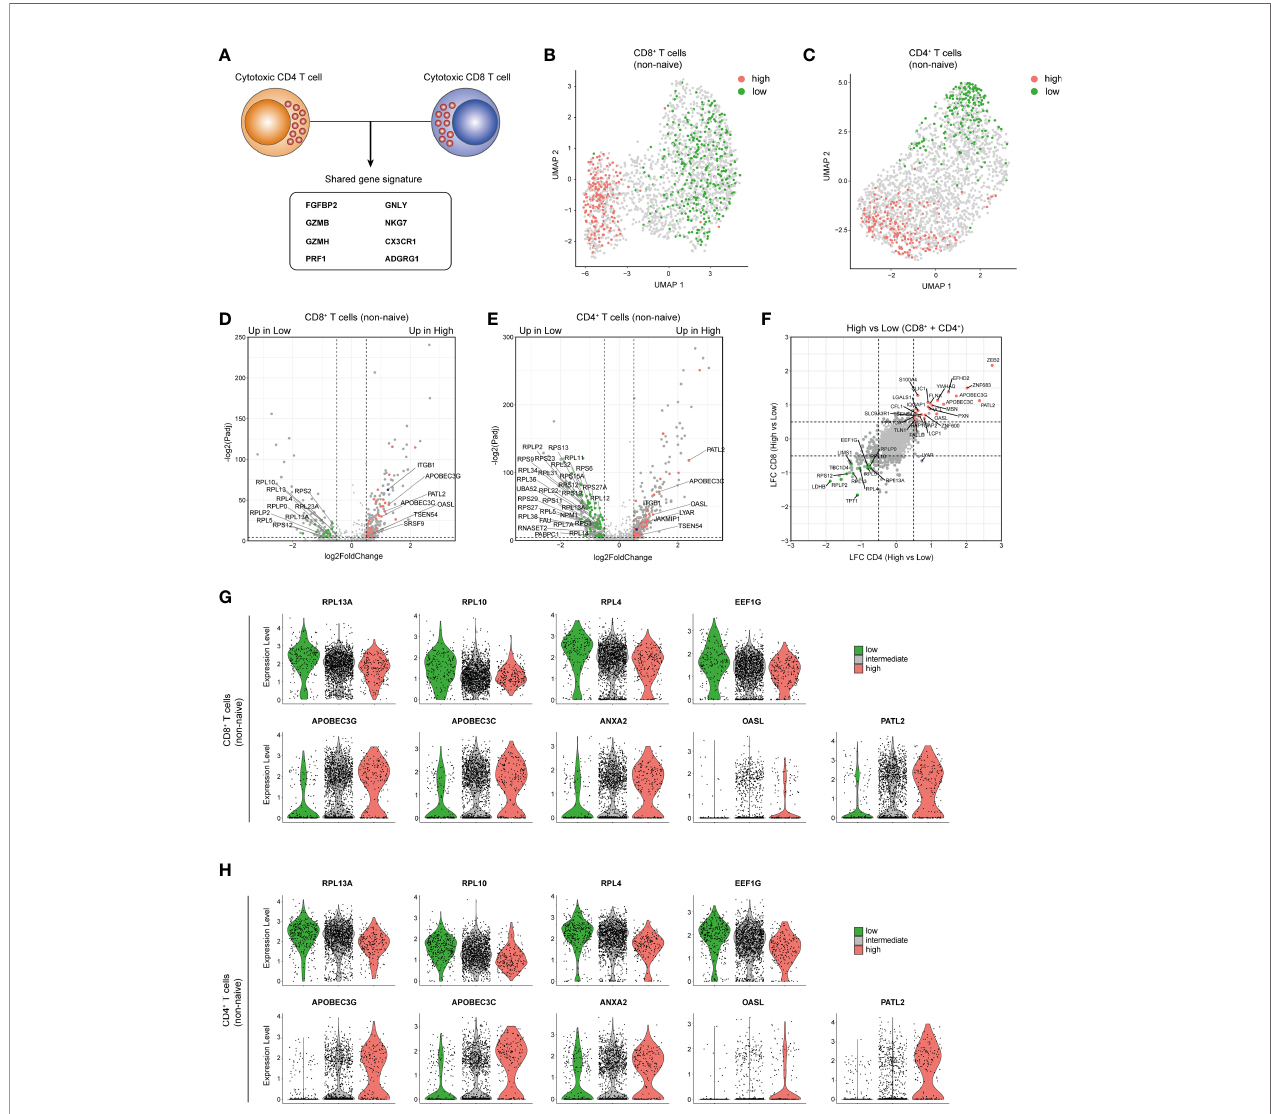
FIGURE 6 | Cytotoxic CD4 + and CD8 + T cells share an RBP expression pro fi le. (A) Diagram indicating the cytotoxic gene signature shared by CD4 + T cells and CD8 + T cells as de fi ned in Supplementary Figures 6E, F . (B, C) Uniform Manifold Approximation and Projection (UMAP) plot on non-naive CD8 + T cells (B) and CD4 + T cells (C) with a high (top 10%, red) or low (bottom 10%, green) cytotoxic score. (D, E) Volcano plot d DE RBPs (red) and other genes (gray) between non- naive CD8 + T cells (D) and CD4 + T cells (E) . Blue dot depicts ITGB1 . (F) Log2 Fold Change values for RBPs with a high or low cytotoxic score of non-naive CD4 + T cells (y-axis) and non-naive CD8 + T cells (x-axis). Red and green dots indicate DE RBPs associated with a high and low cytotoxic score in both T cell types (LFC>0.5 P-adjusted<0.05). (G, H) Violin plots depicting expression levels and expression density of selected RBPs in CD8 + T cells (G) or CD4 + T cells (H) with a high (top 10%), intermediate (10-90%) or low (bottom 10%) cytotoxic